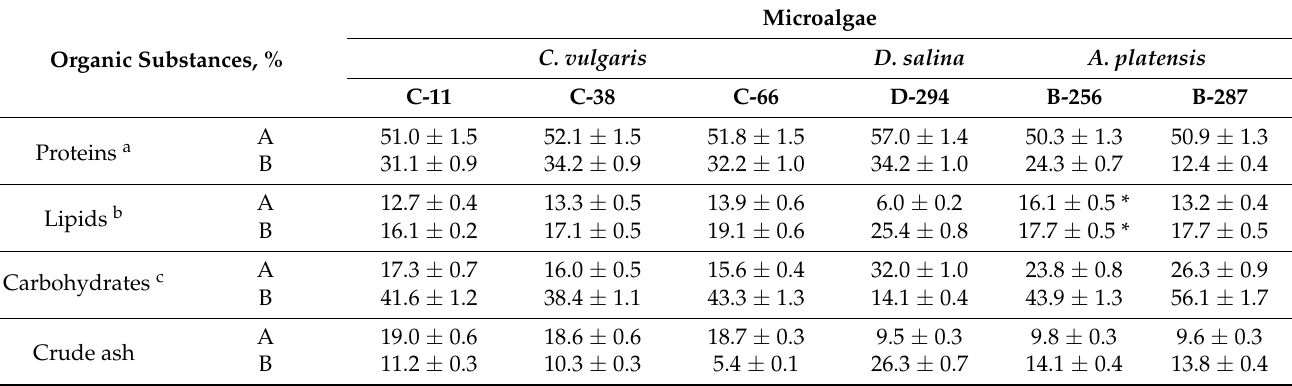
Table 6. Content of proteins, carbohydrates, and lipids (%) in 100 g of dried microalgae without (A) and with (B) the addition of